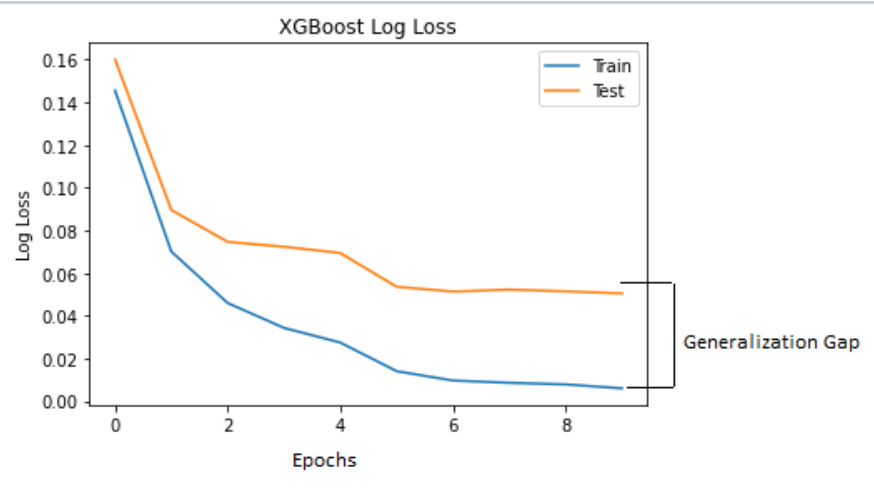
Figure 8. XGBoost log loss